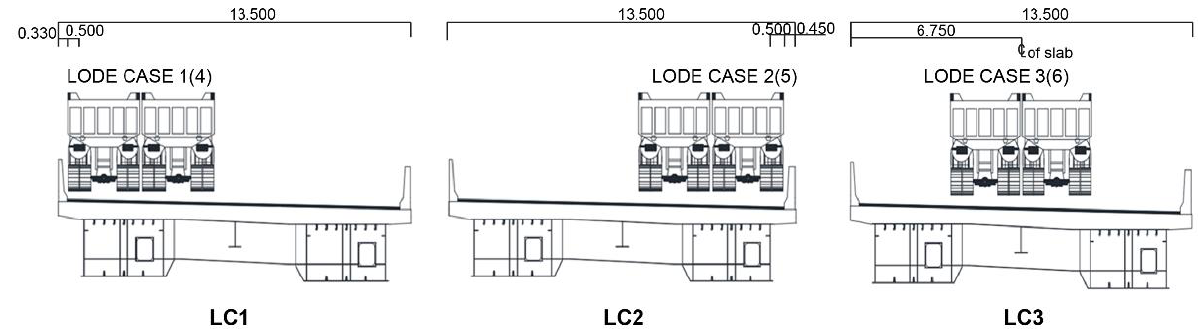
Figure 7. Positions of the test loading truck during the static loading test.